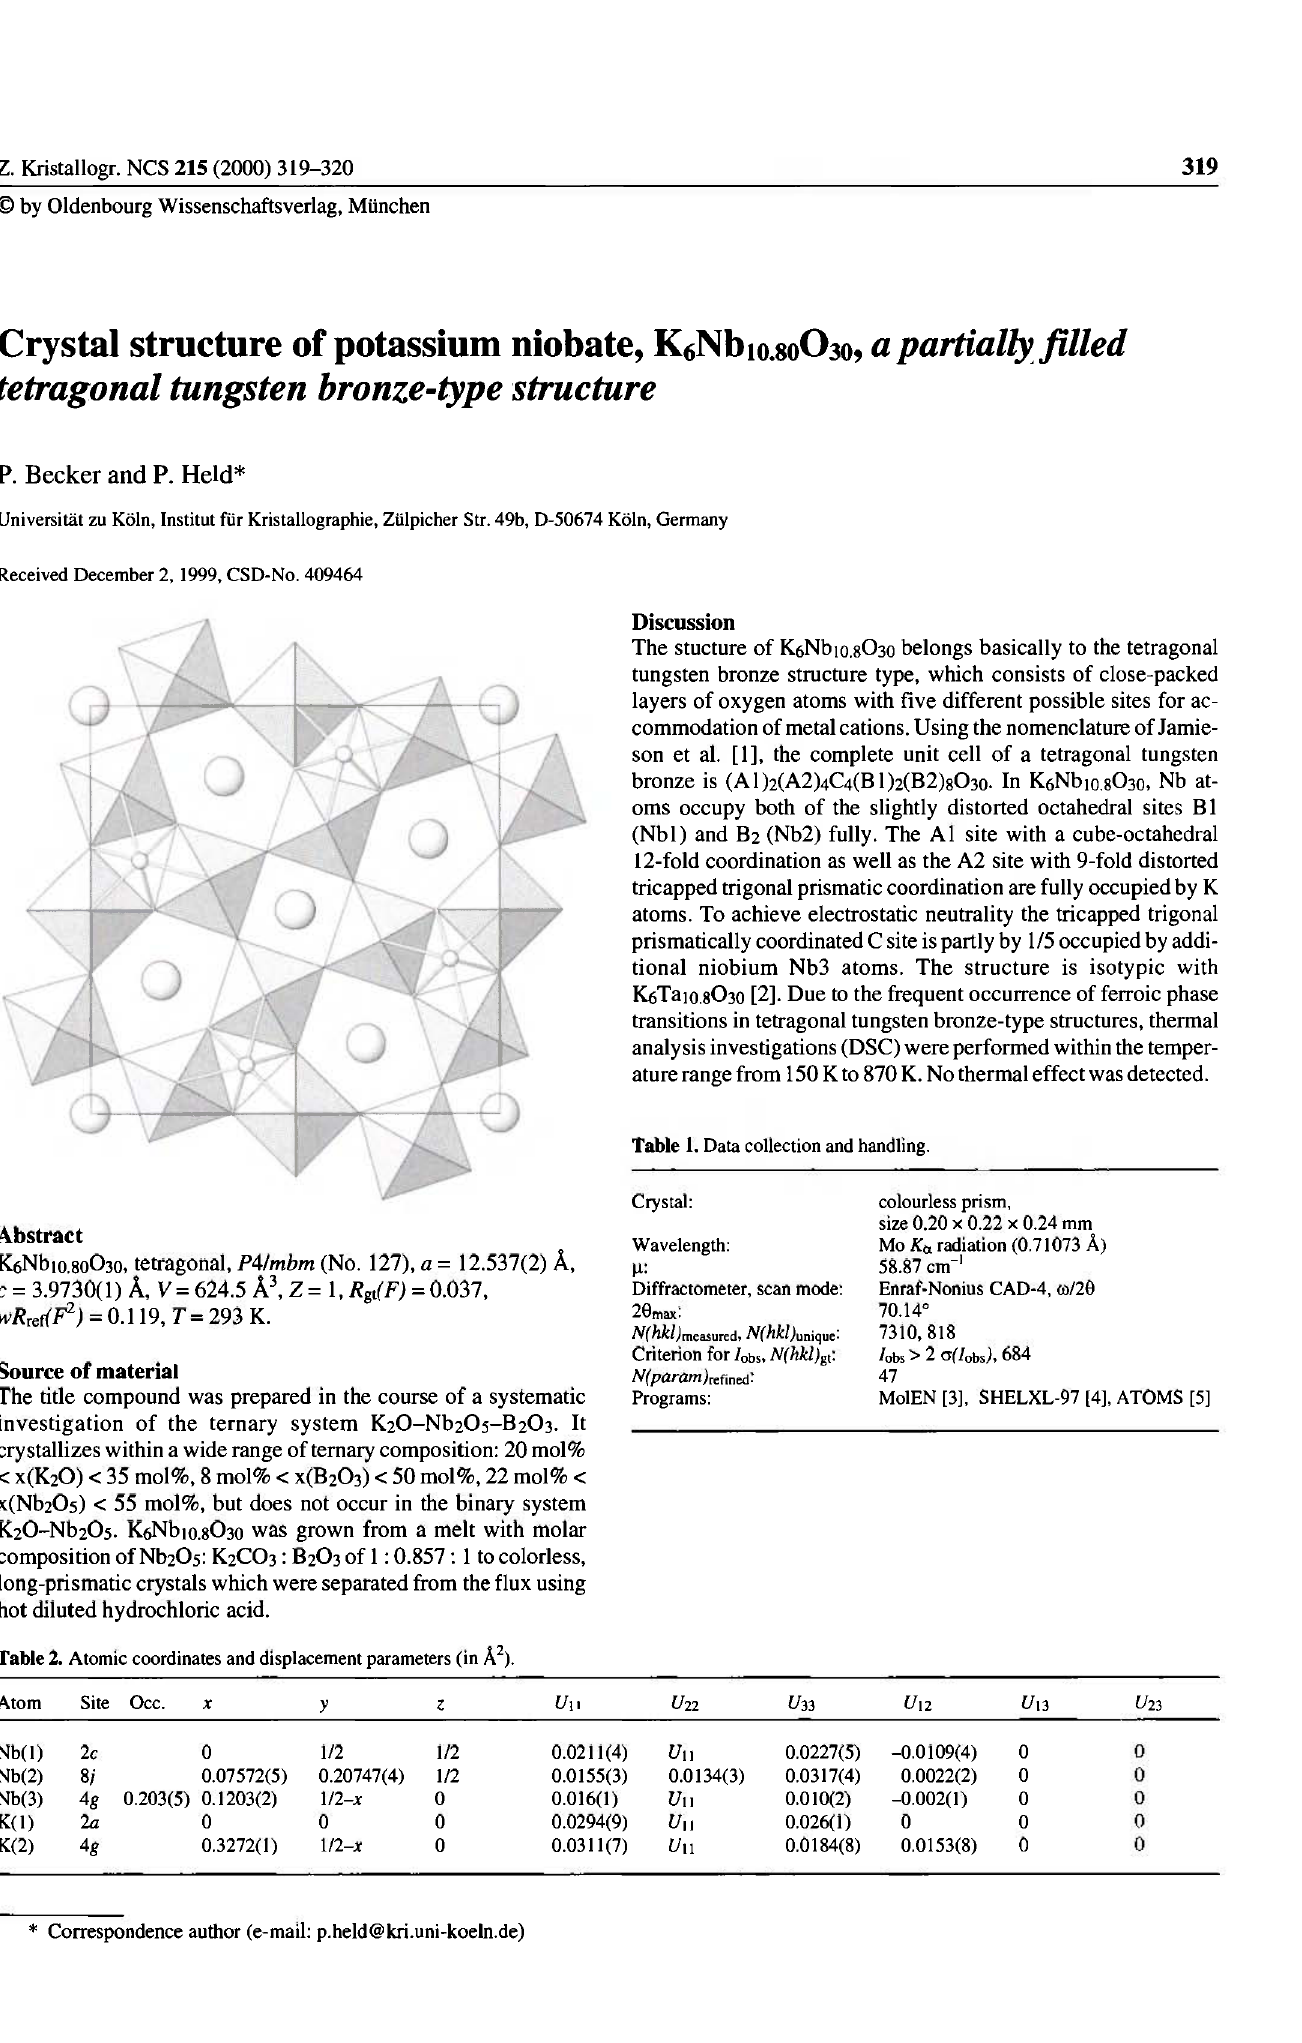
Table 2. Atomic coordinates and displacement parameters (in Ä 2